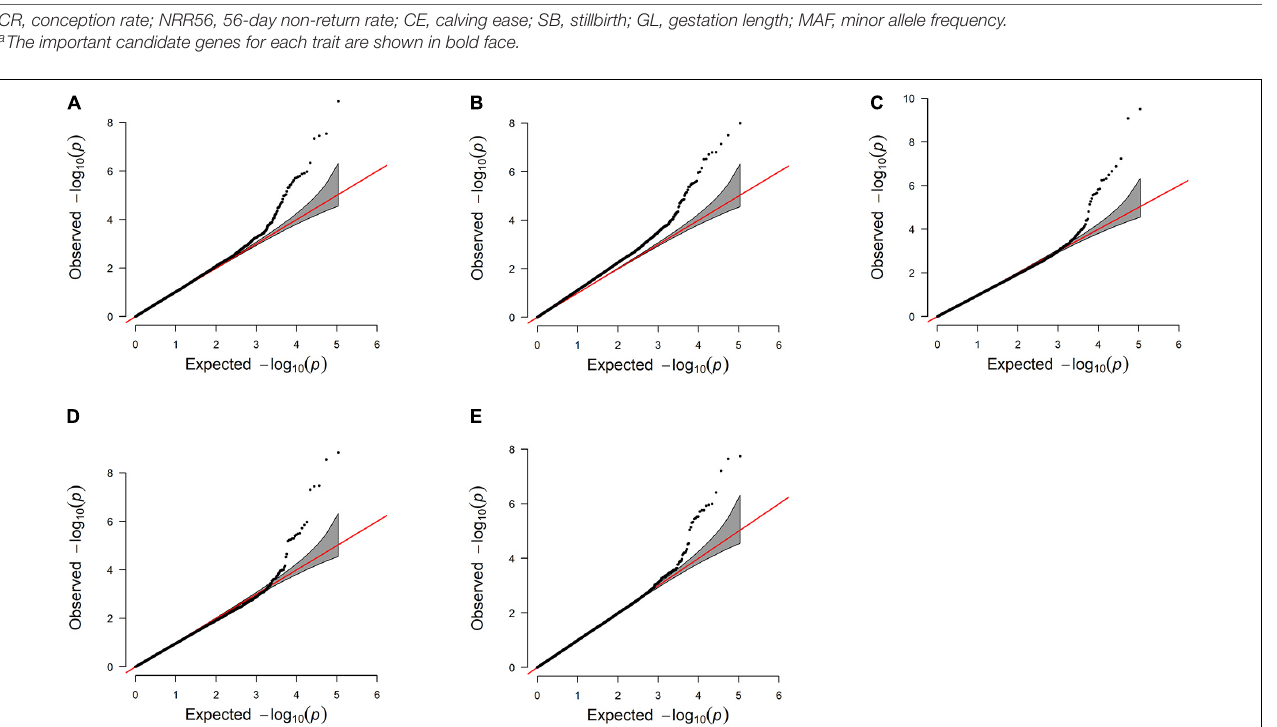
and SB (0.07–0.13) (Van Tassell et al., 2003; Heringstad et al., 2007). The S-MGS model converted the direct and maternal variances to sire and maternal grandsire variances, which was, to some extent, different from those of the present study. Due to the differences in the model used in the current study, here we simply compare our findings with the results of the S-MGS model from previous studies. The maternal heritabilities estimated by other models ranged from 0.01 to 0.13 for GL (Jamrozik et al., 2005; Crews, 2006; Mujibi and Crews, 2009) and 0.02–0.08